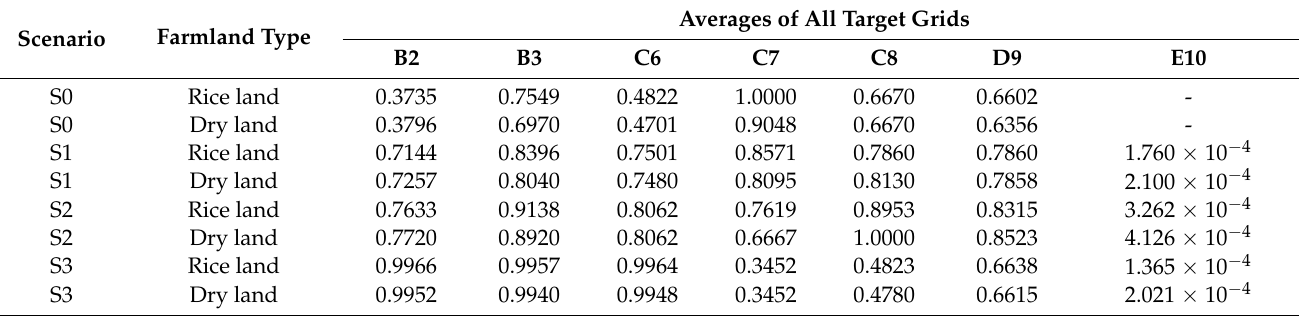
Table 5. Averages of all target grids of nodes of the SMCE model. B2: low-nitrogen degree of water; B3: low-phosphorus degree of water; C6: environmental effect of farmland; C7: economic effect of farmland; C8: social effect of farmland; D9: comprehensive effect of farmland; E10: comprehensive effect increment of per unit compensation cost of each grid; S0: current situation; S1: halving fertilization every year; S2: fallow every other year; S3: returning agricultural land to